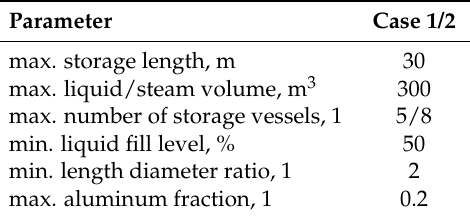
Table 6. Limits for storage